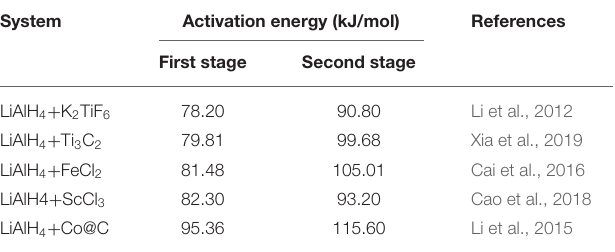
TABLE 1 | Activation energy of catalyst-doped LiAlH 4 from previous